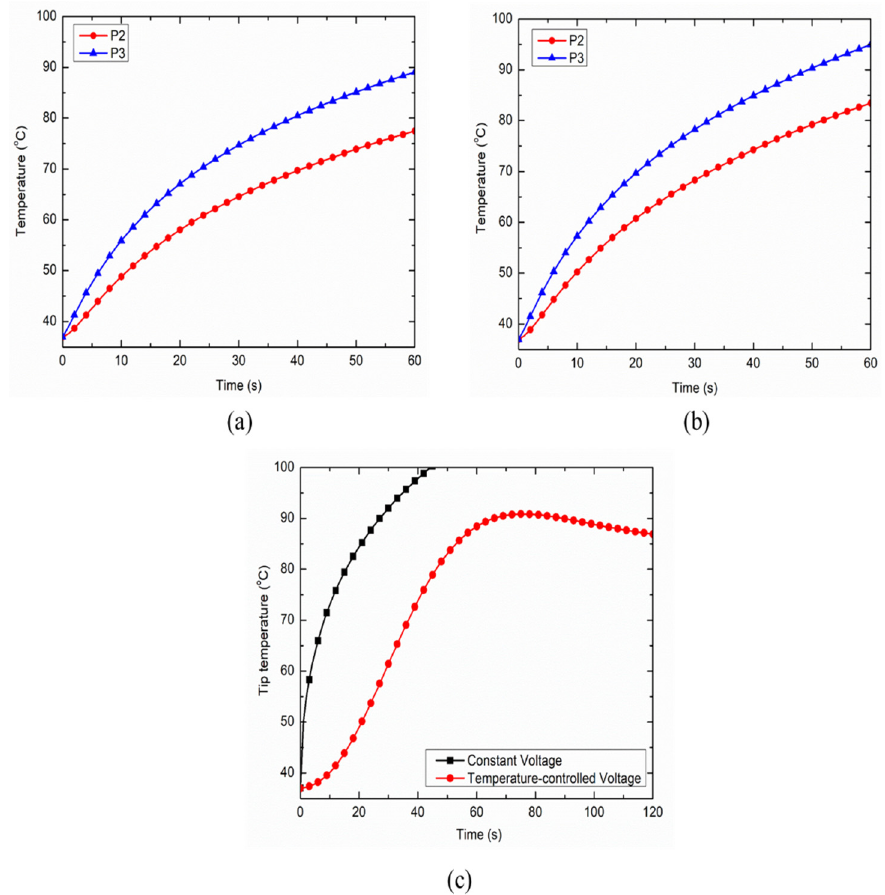
Figure 7. Variation in temperature distribution as a function of time at points P2 and P3 for the heterogeneous computational domain comprising of: ( a ) nerve, bone and muscle tissues, and ( b ) nerve and muscle tissues. ( c ) Variation in the target tip temperature as a function of treatment time for constant voltage and temperature-controlled protocols of power delivery during the continuous RF procedure for pain